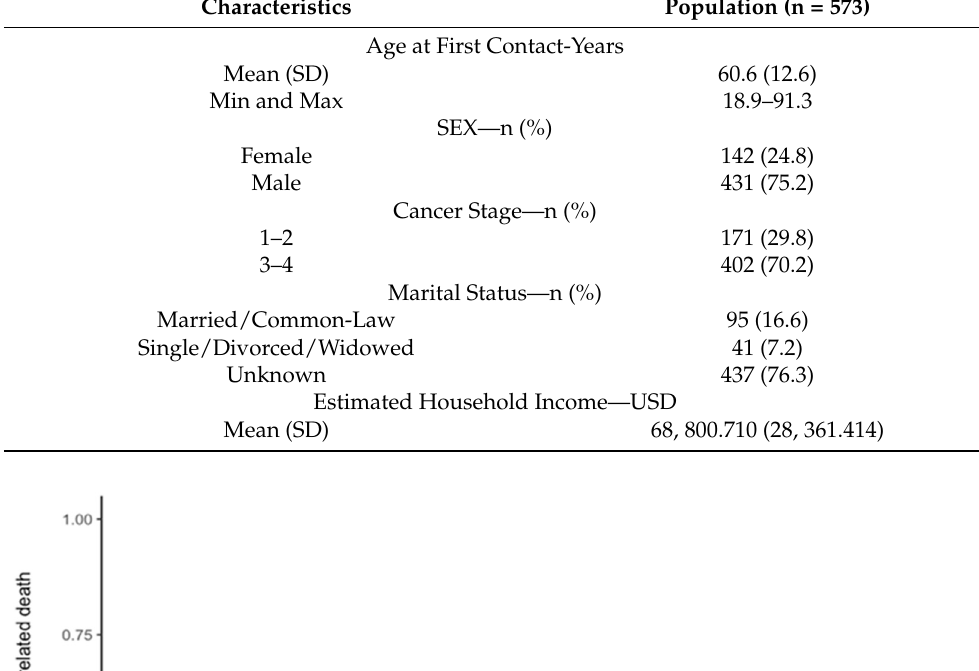
Table 3. Baseline characteristics of Aim 2 study population.